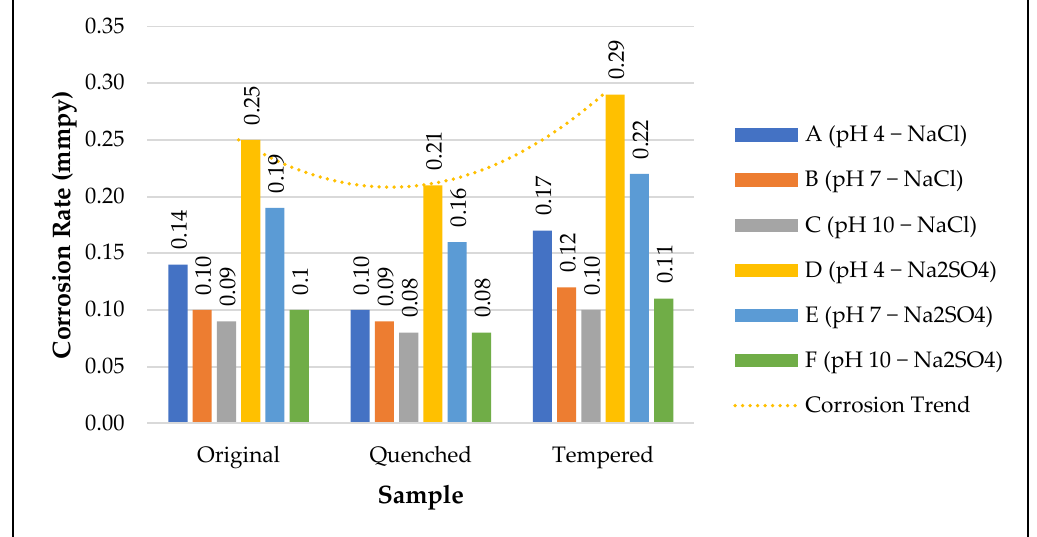
Figure 15. Relation between O, Q, T vs. Corrosion Rate.